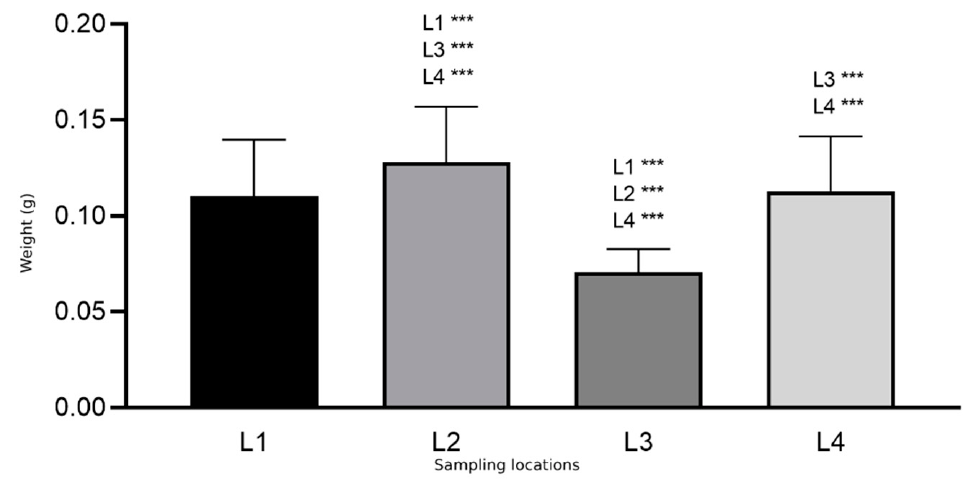
Figure 5. Weight means values of the emerged adult Osmia cornuta at different locations. Asterisks indicates statistically significant differences: L2 vs. L1, L3, L4; L3 vs. L1, L2, L4; L4 vs. L3; *** p < 0.0001; mean ± SD. The overall bee emergence weight statistic based on the number of healthy bees and their species differentiation is shown in Table